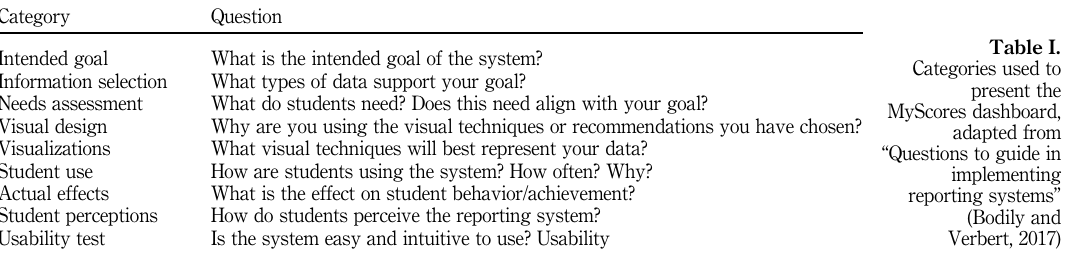
Table I. Categories used to present the MyScores dashboard, adapted from “ Questions to guide